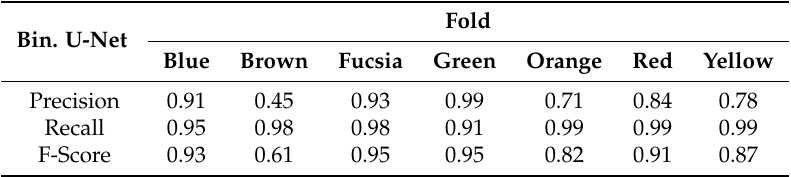
Table 4. Binary U-Net cross-validation results for the binary classification